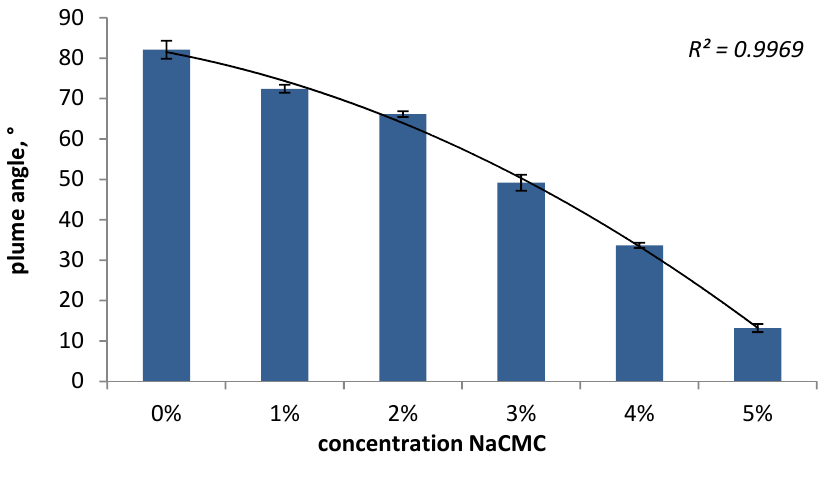
Figure 5. The influence of viscosity on the plume angle.